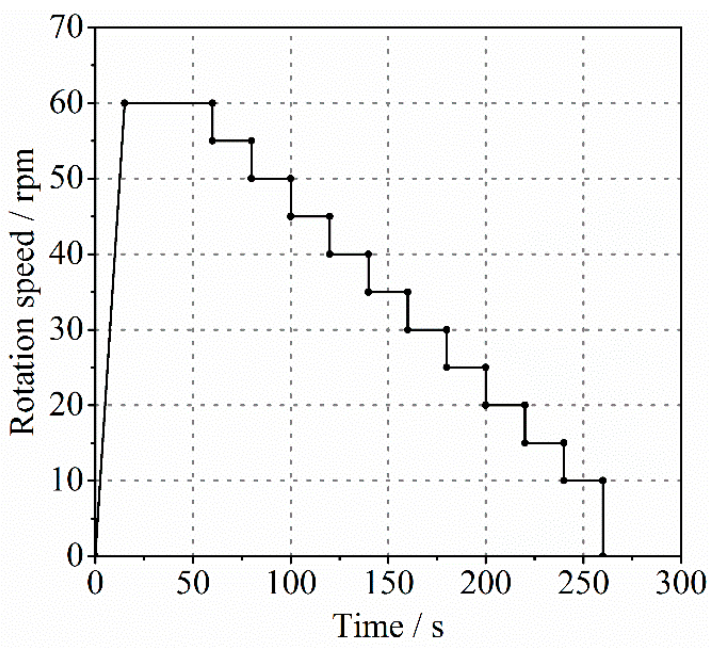
Figure 2. The testing scheme for measuring rheological parameters of concrete. Simultaneously, the slump flow and V-Funnel flow time of different concrete were determined according to the Chinese national standard GB/T 50080-2016 to investigate the variation of its